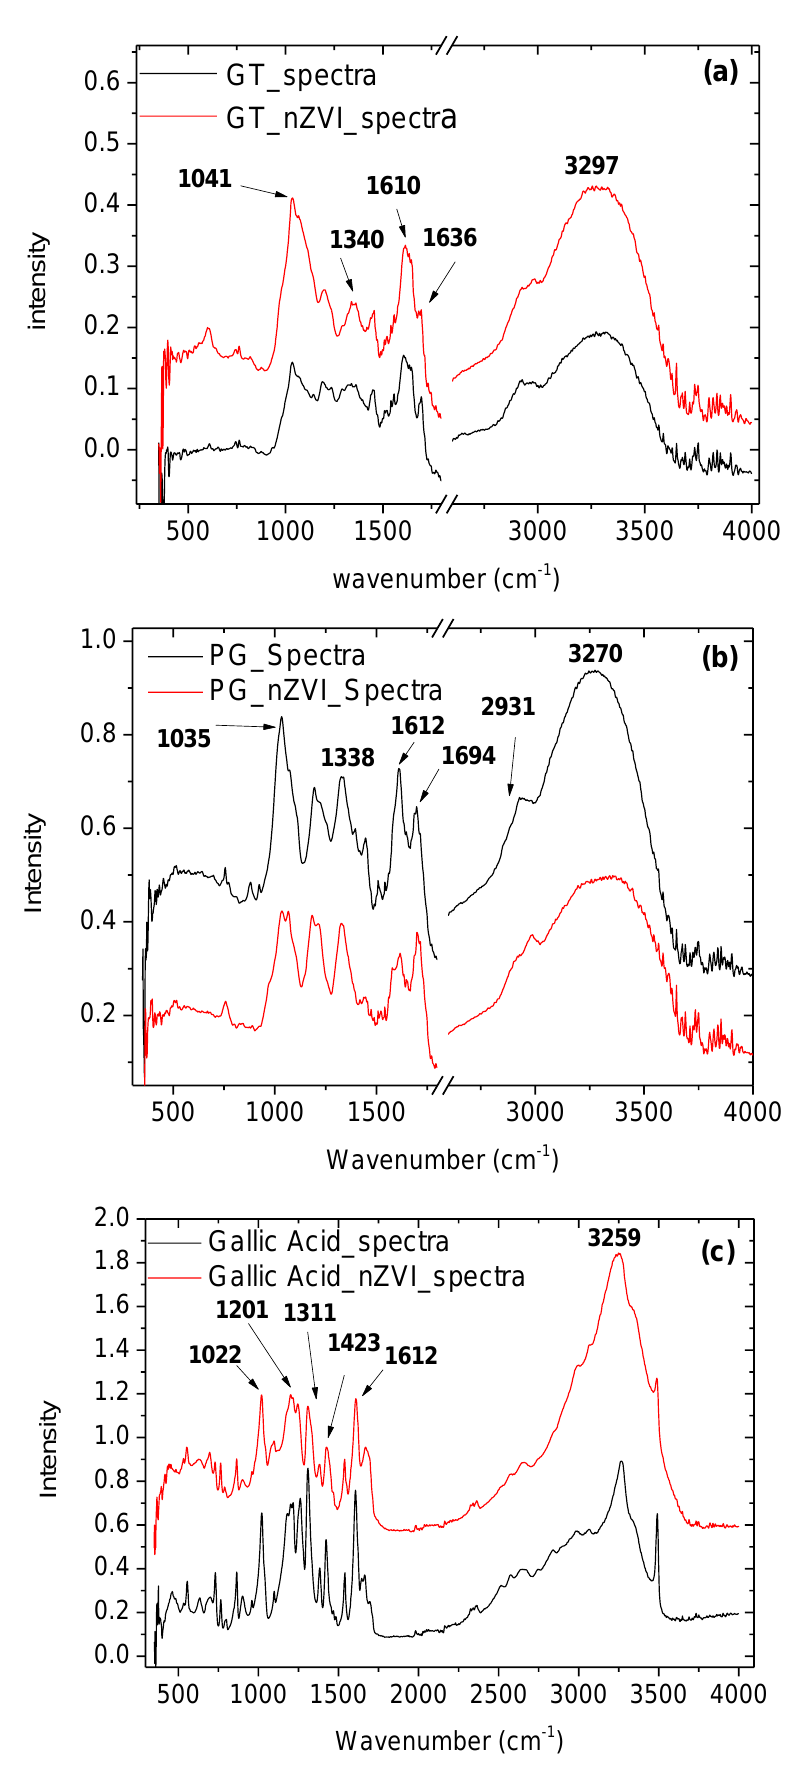
Figure 7. ATR-FTIR spectra of: (a) GT and GT-nZVI; (b) PG and PG-nZVI; (c) GA and